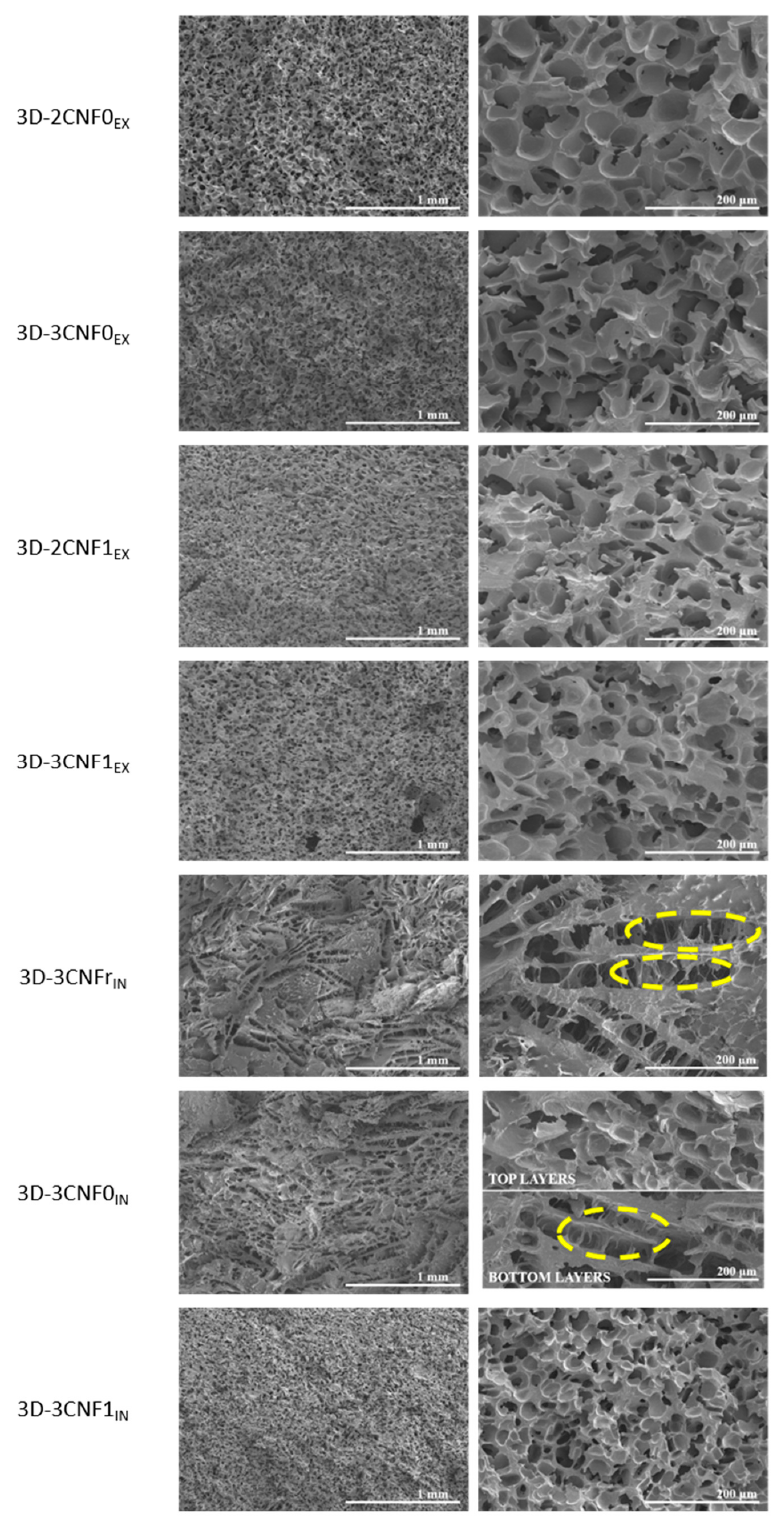
Figure 7. SEM images of 3D-printed parts from CNF-containing inks. ( left ) ×50 and ( right ) ×250 magnification. (Yellow circles show collapsed cell walls).